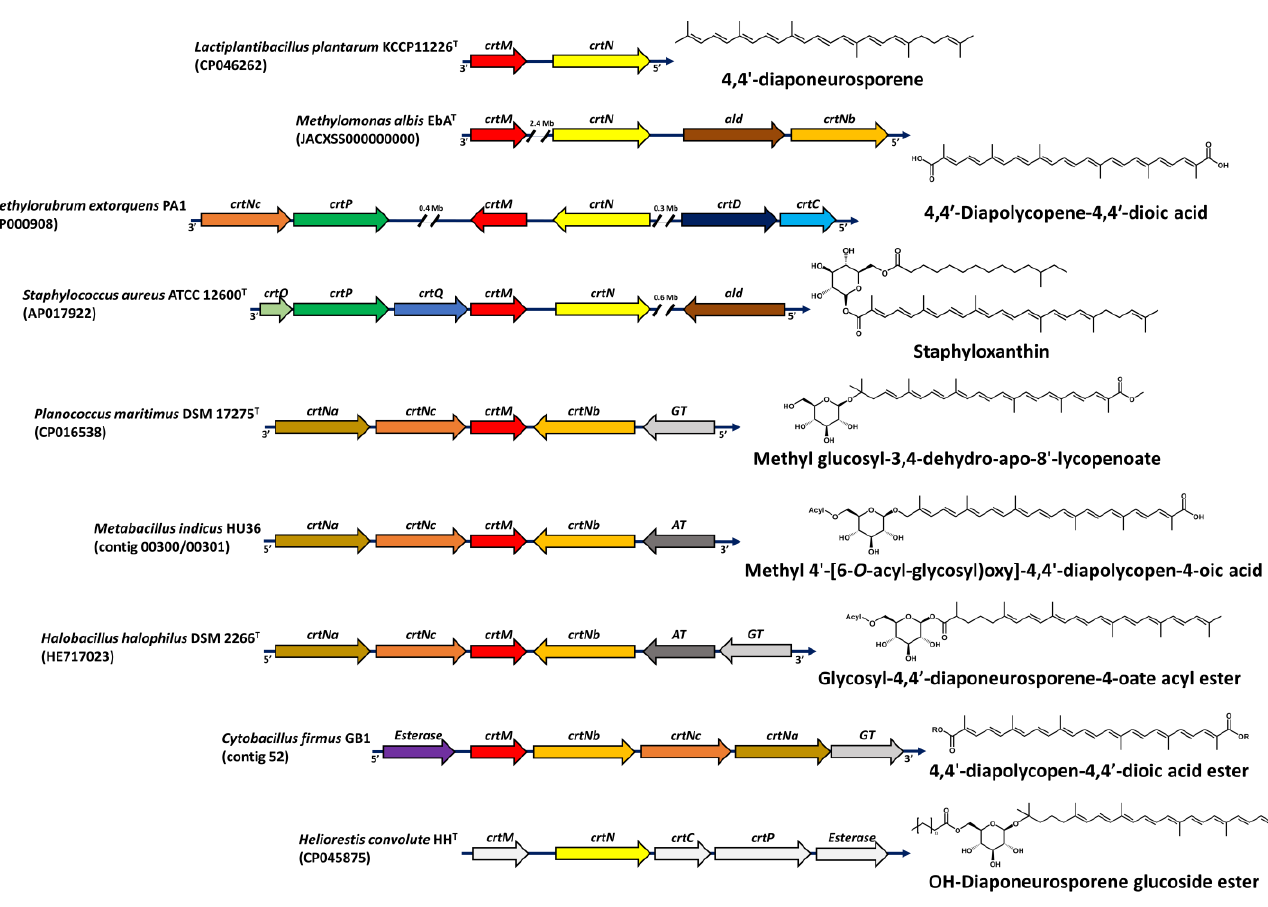
Figure 5. Gene clusters of 4,4′ -diapocarotenoids and apo- 8′ -carotenoids from various microbial sources. White arrows represent putative genes in the biosynthetic pathway, including new and novel carotenoids.